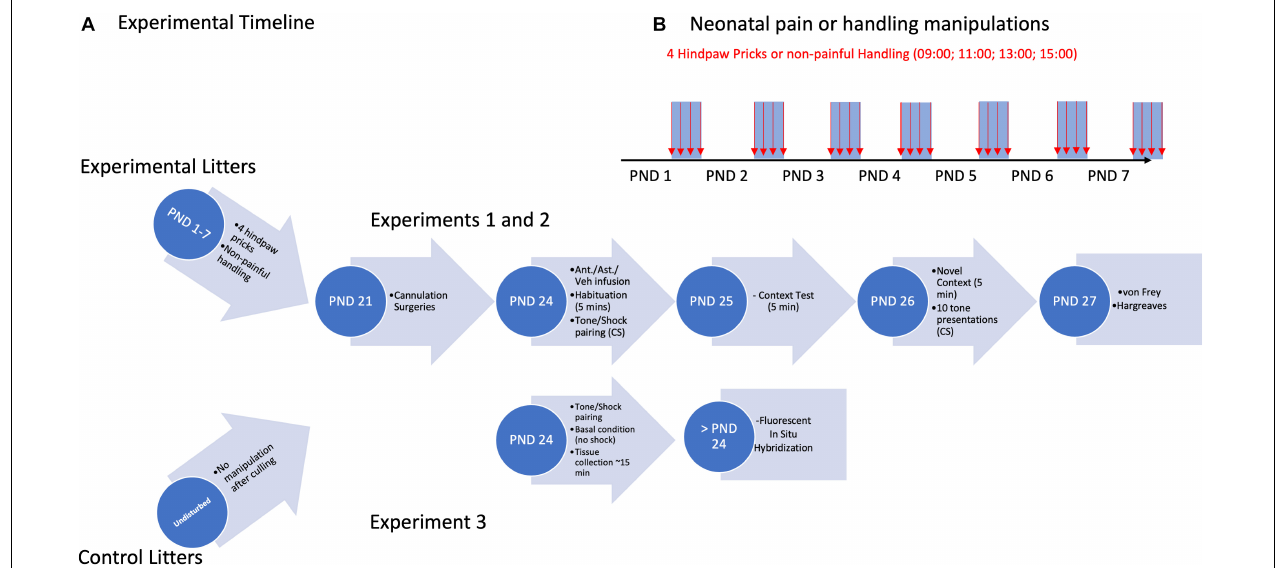
FIGURE 1 | Experimental timeline (A) for cannulation Experiments 1 and 2, and CeA/BLA CRF expression Experiment 3. Overview of neonatal pain/handling manipulations (B) for all three